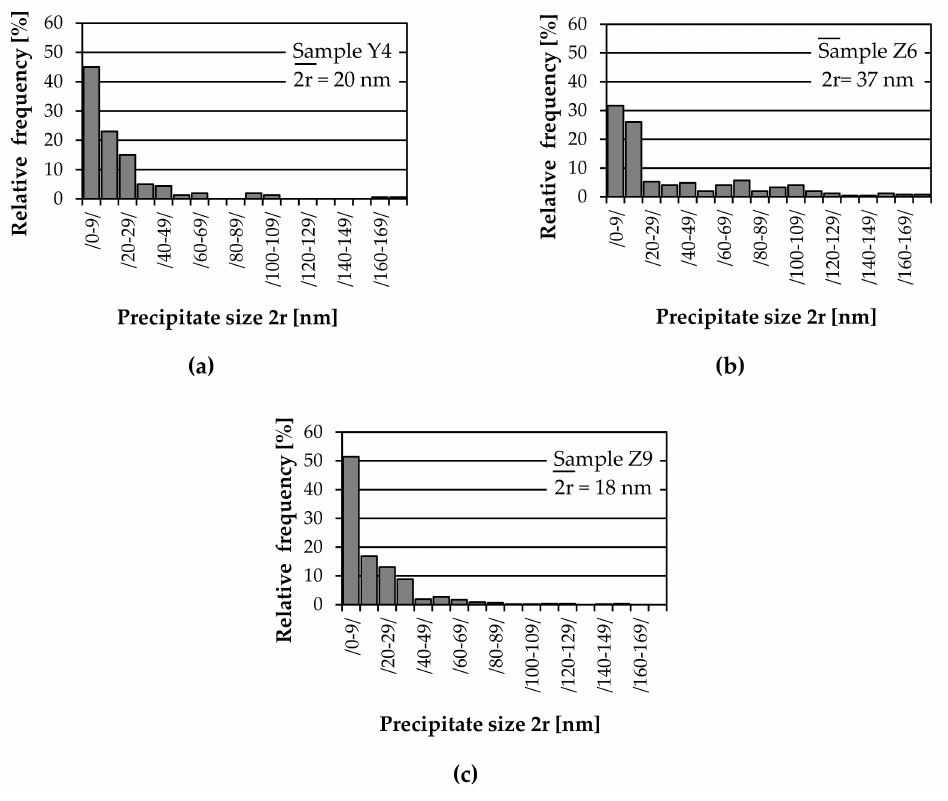
Figure 12. Relative frequency of particles by size for samples: ( a ) CT1150-2 ◦ , T d = 1050 ◦ C, N f = 95.4,